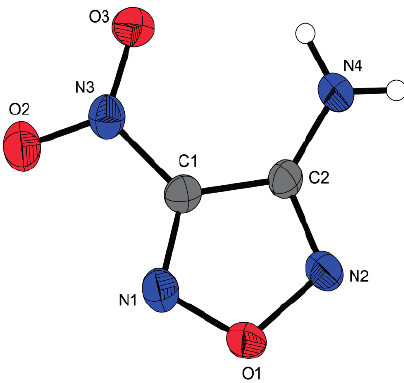
Figure 2. Molecular unit of 3 . Ellipsoids are drawn at the 50% probability level.